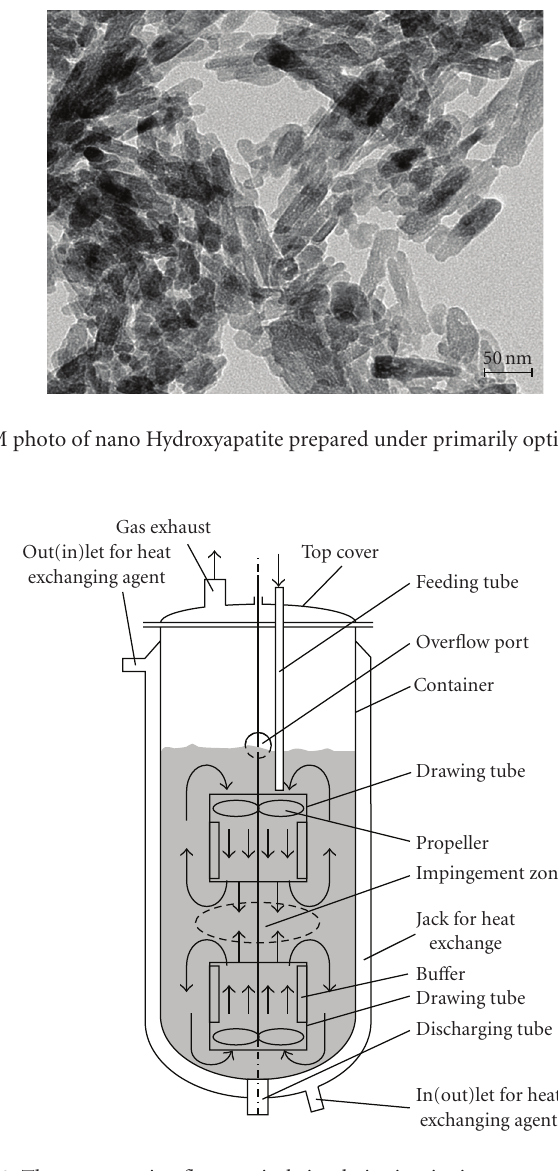
Figure 10: The non-rotating flow vertical circulative impinging stream reactor [37].